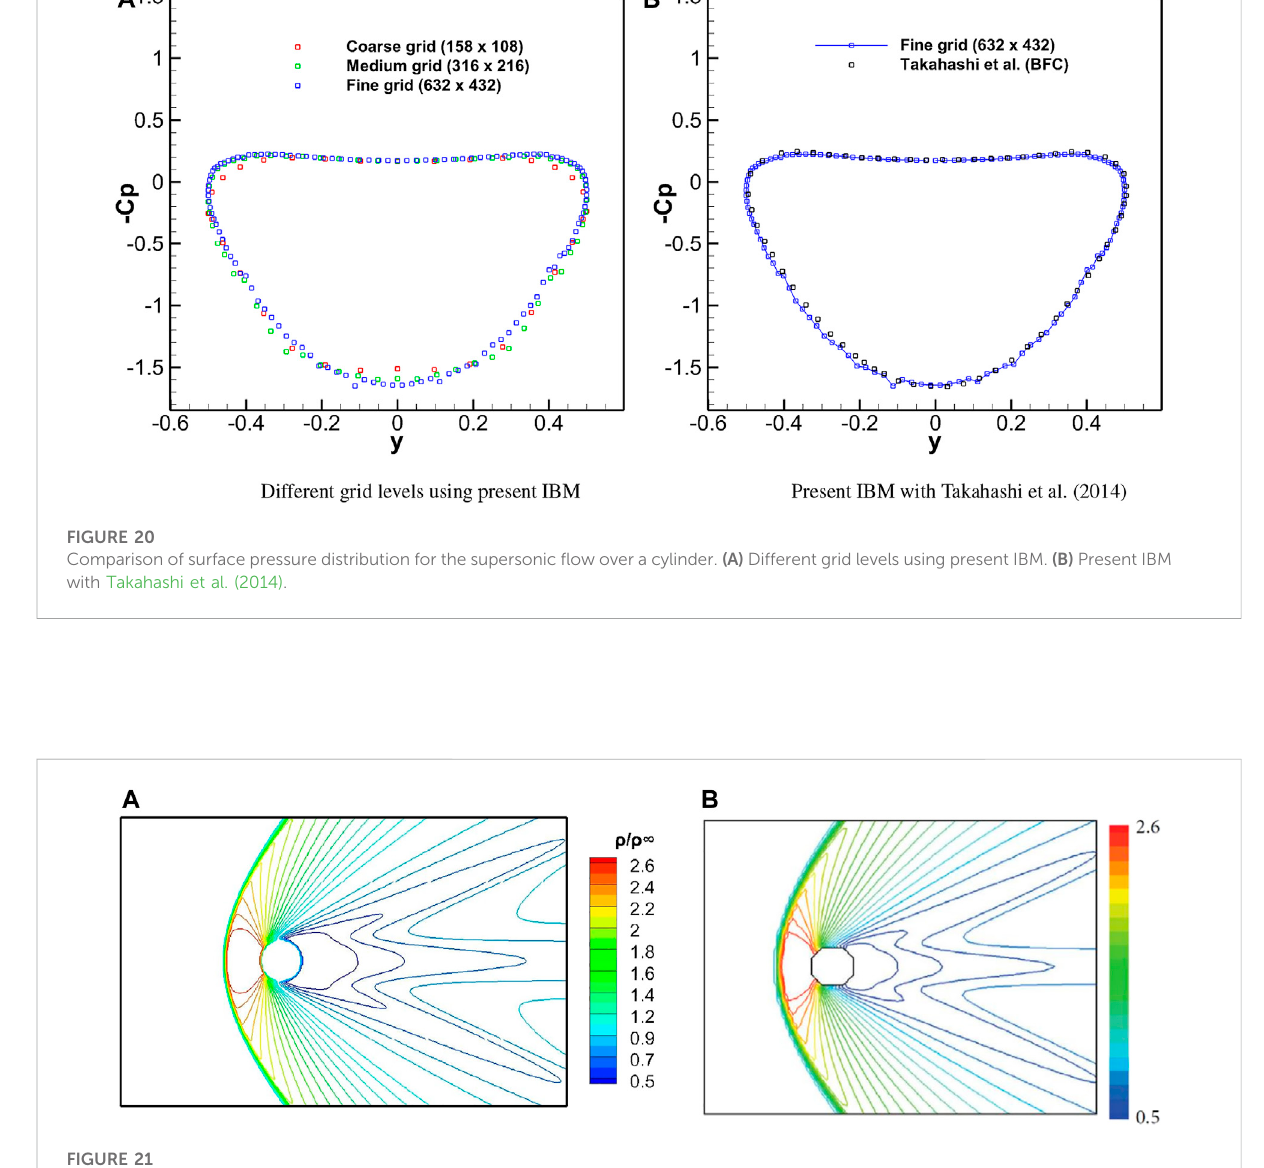
respectively. The exact values of the lift and drag coef fi cients are listed in Table 2.